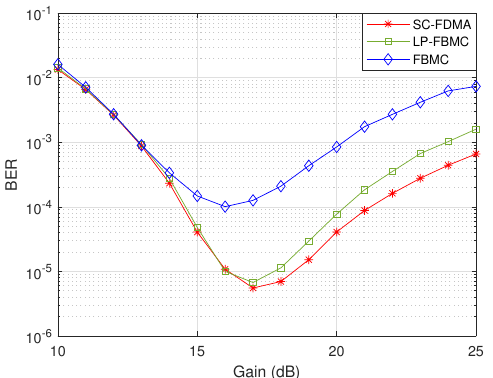
Figure 12. BER of the SC-FDMA, FBMC, and LP-FBMC according to the transmit power amplification gain, F = 700 MHz, distance between TX and RX = 12 m, LoS